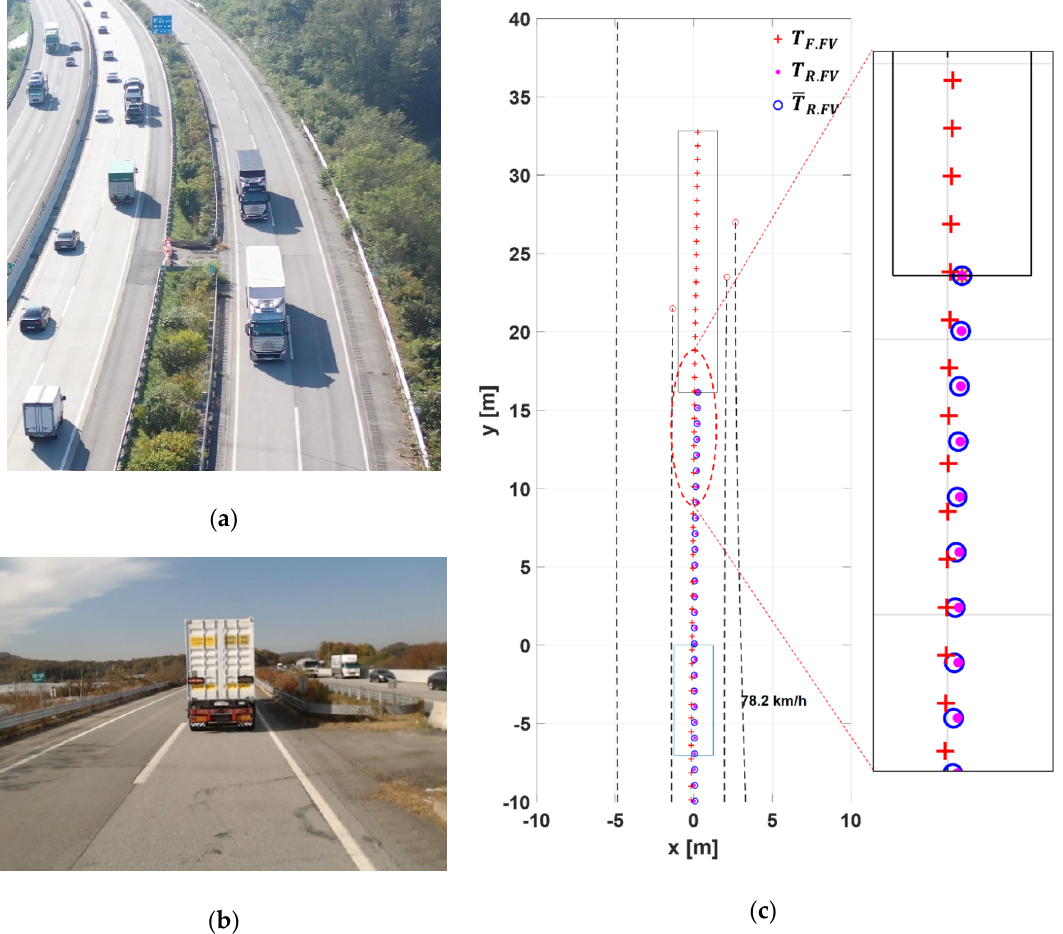
Figure 23. The test results for Scenario T1. ( a ) Top-view of the platooning trucks; ( b ) front-camera view of FV; ( c ) LV trajectories generated by FV in FV coordinate system.